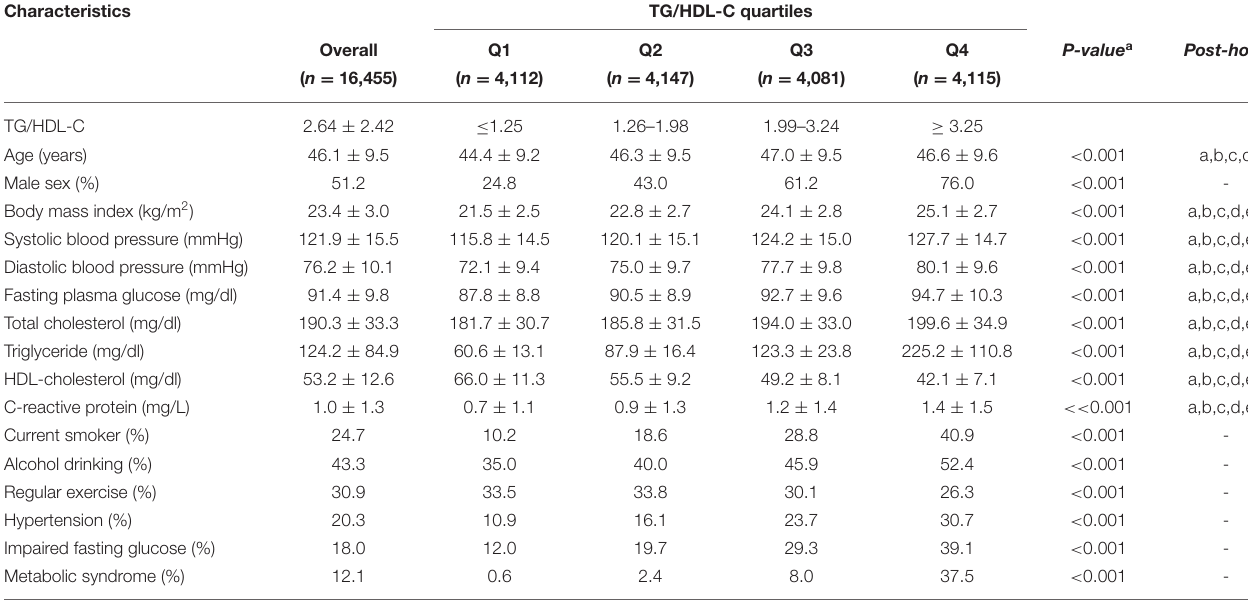
TABLE 1 | Baseline characteristics of the study population according to the TG/HDL-C quartiles. Characteristics